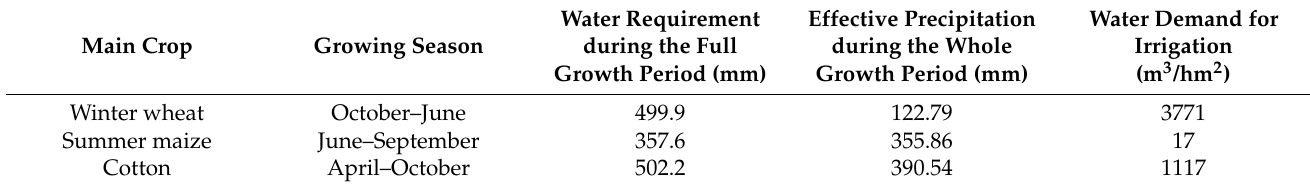
Table 1. Irrigation water consumption of the main crops in Quzhou